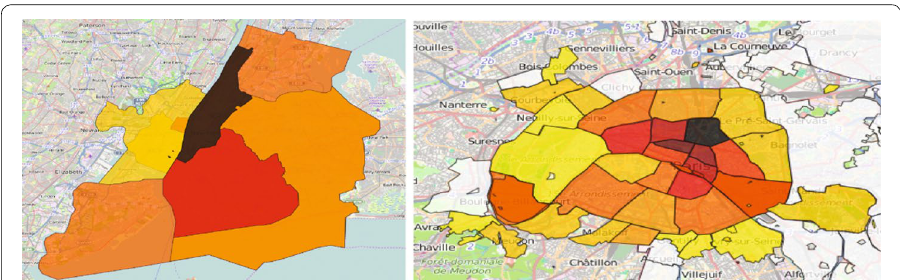
Fig. 10 Polygons computed for New York and Paris [23]